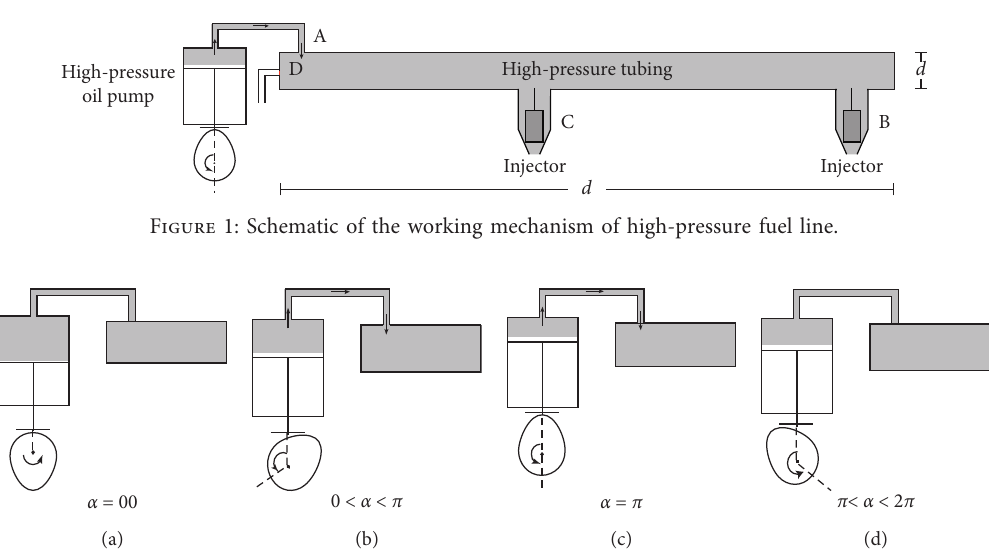
Figure 2: Schematic of the working mechanism of high-pressure fuel pump. (a) α � 0. (b) 0 < α < π . (c) α � π . (d) π < α < 2 π .